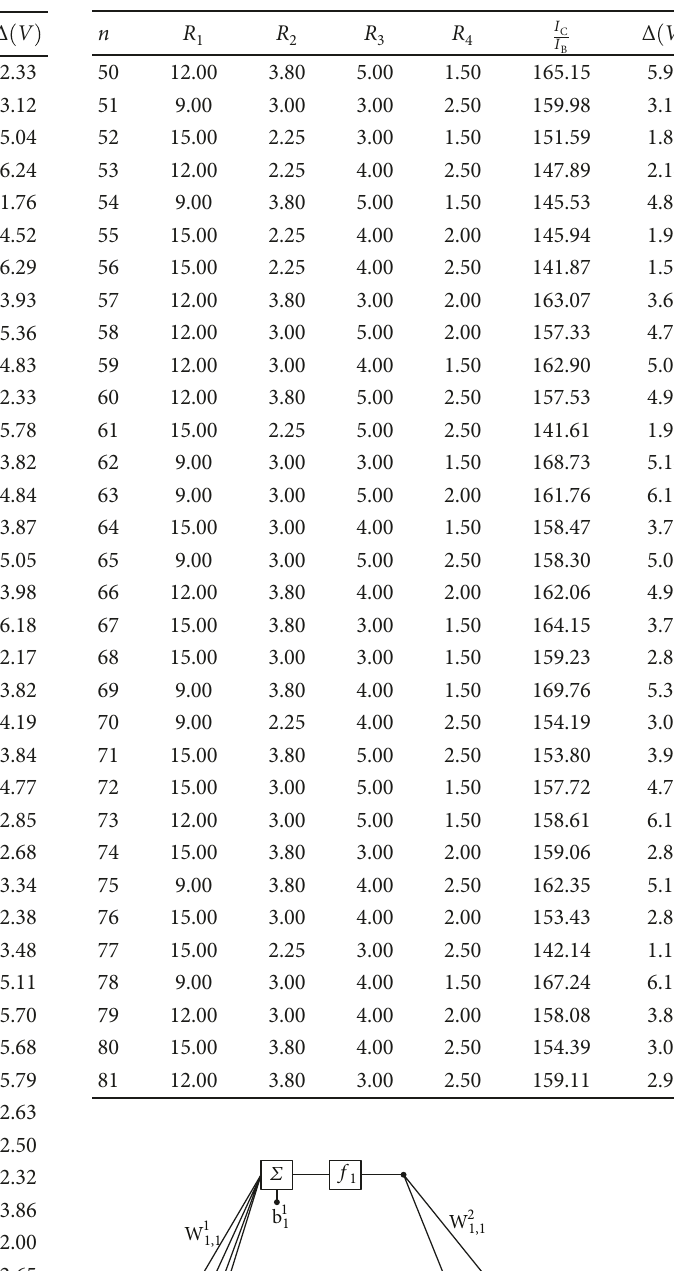
Table 2: Gain voltage Δ V and I